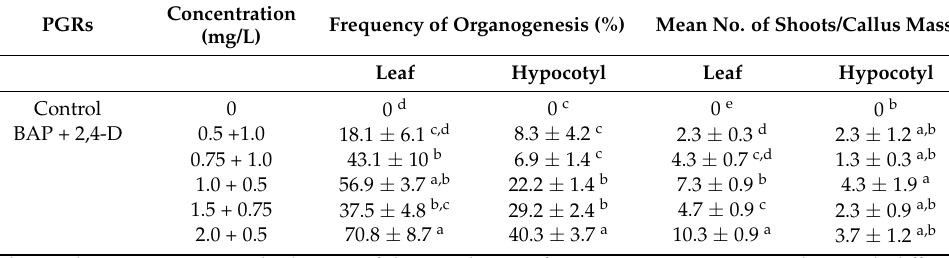
Table 5. Effect of BAP and 2,4-D on shoot organogenesis from leaf and hypocotyl callus in D. purpurea